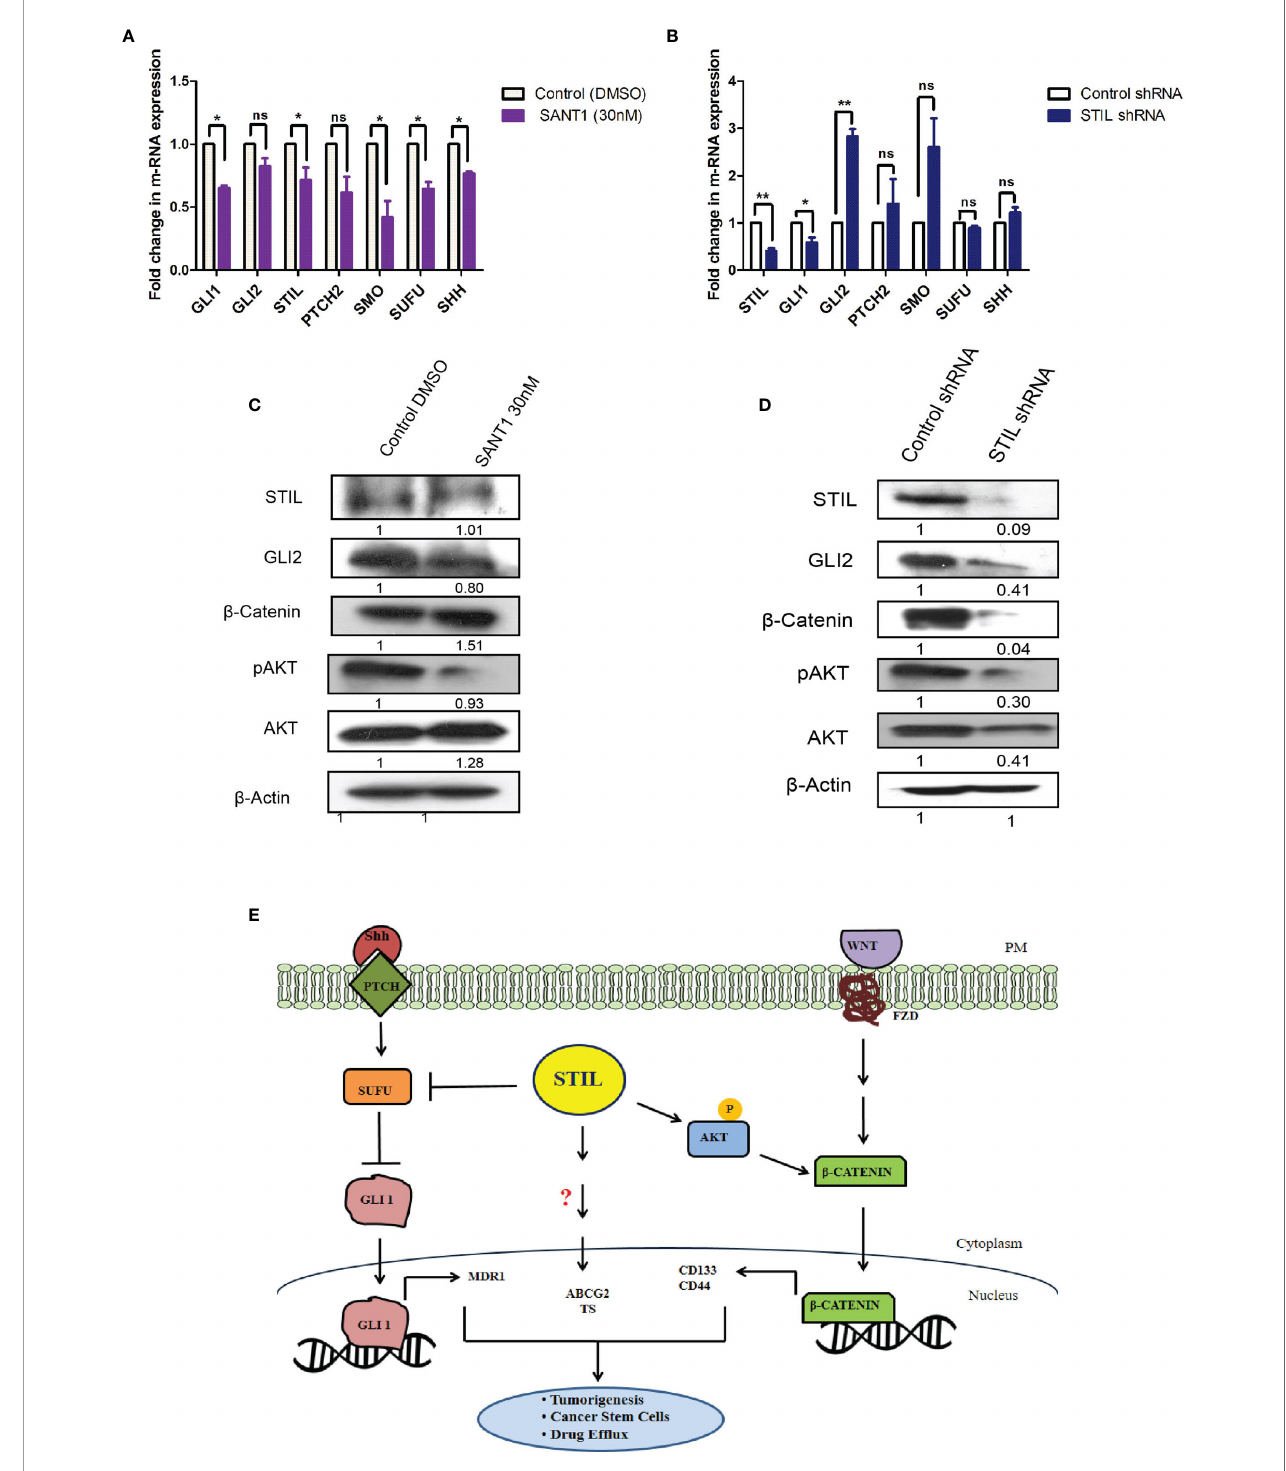
FIGURE 6 | Effect of SANT1 treatment and STIL inhibition on Shh and Wnt signaling. (A, B) Bar graph showing expression of Shh signaling components upon SANT1 treatment and STIL silencing. (C, D) Western blot showing effect of SANT1 treatment and STIL silencing on GLI2, b -catenin, AKT, and p-AKT protein expression. (E) Schematic representation showing possible mechanistic regulation of multifaceted role by STIL in CRC. Unpaired t-test results showing p value ≤ 0.05, ≤ 0.01 are represented by *, **, respectively; ns, not signi fi